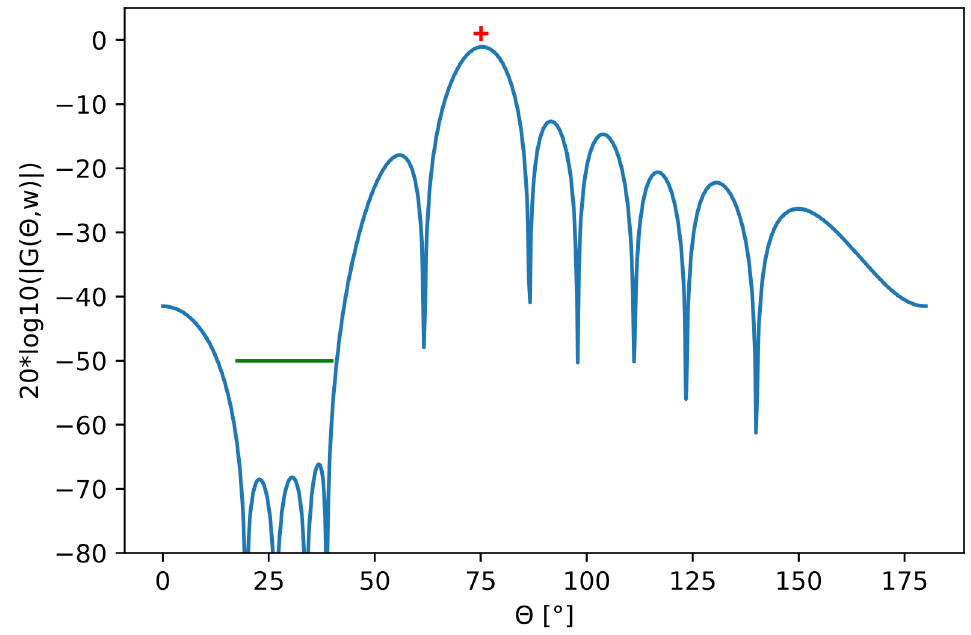
Figure 3. Example of optimized beampattern (blue) with suppression region marked out in green. The red cross is the direction of the beampattern